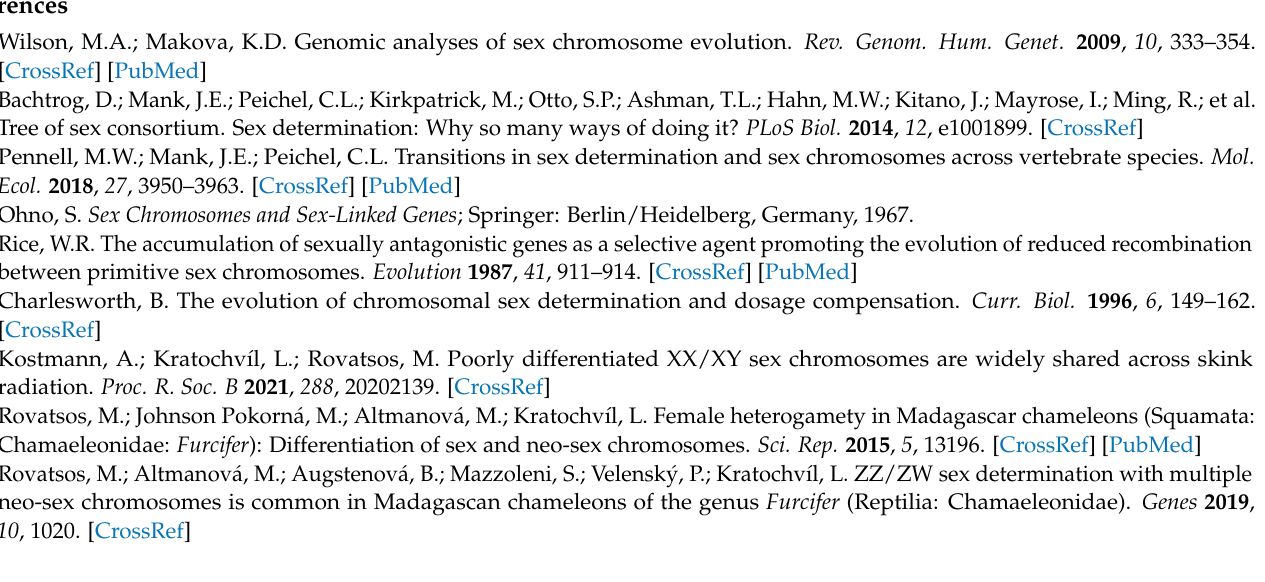
Table S2: Primers and results of the qPCR test for estimating the sex chromosome constitution in the triploid Varanus primordius